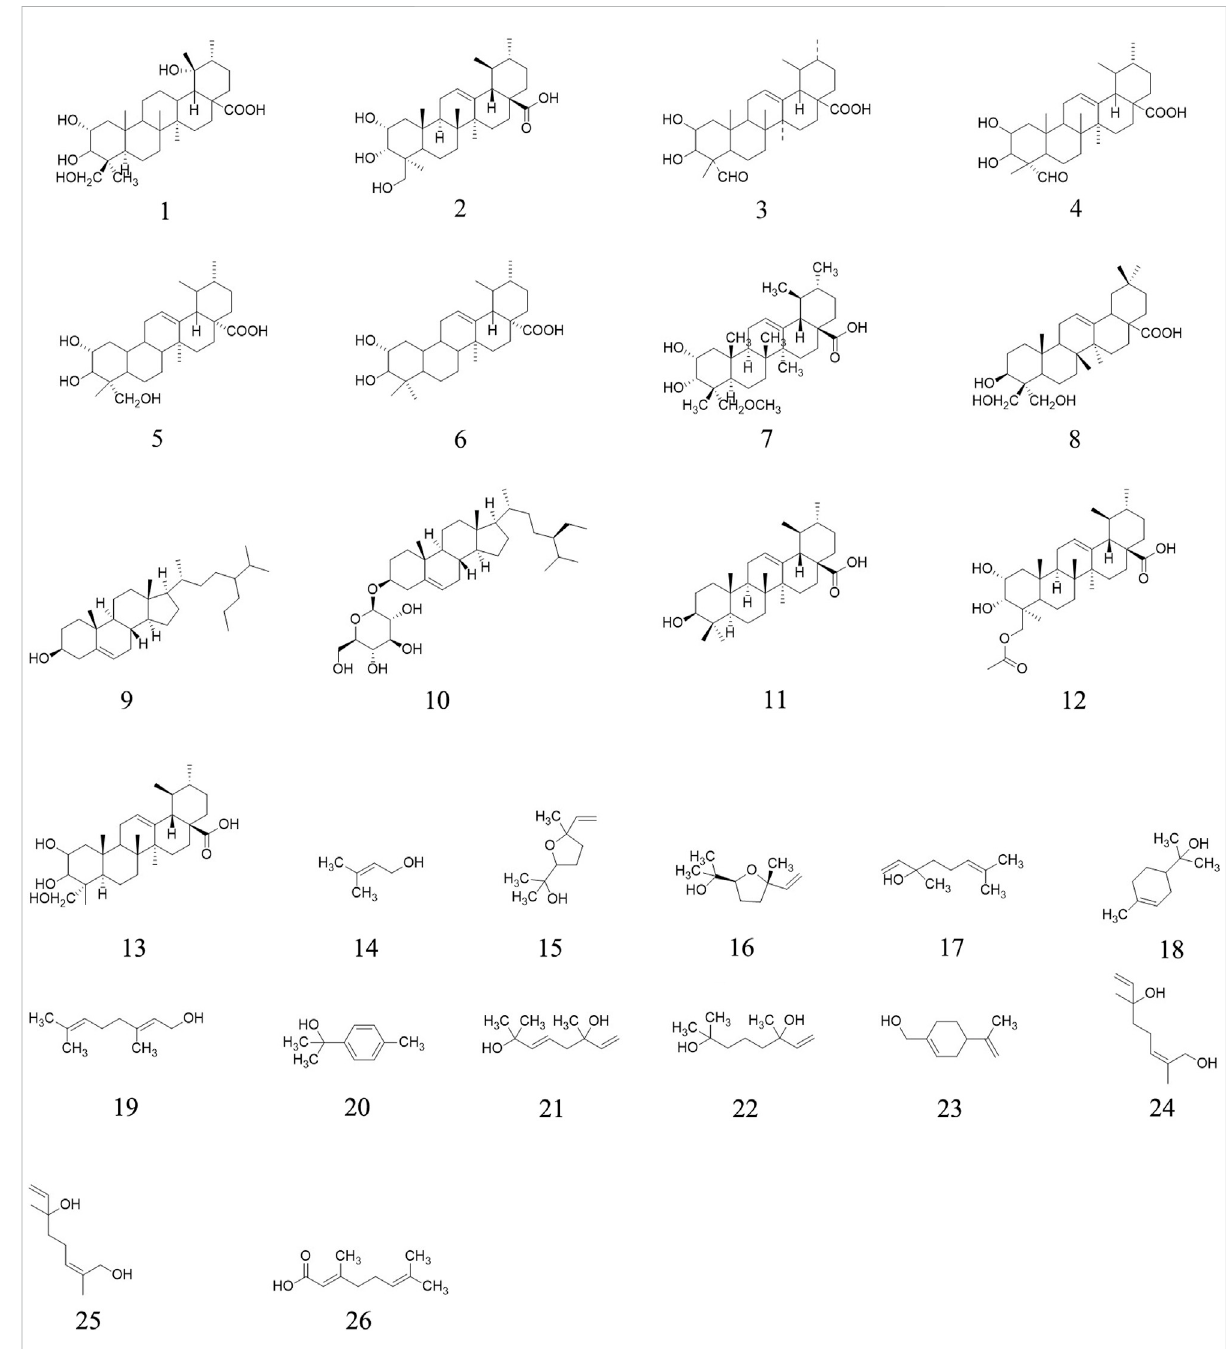
FIGURE 2 Triterpenoids isolated or determined from A. eriantha